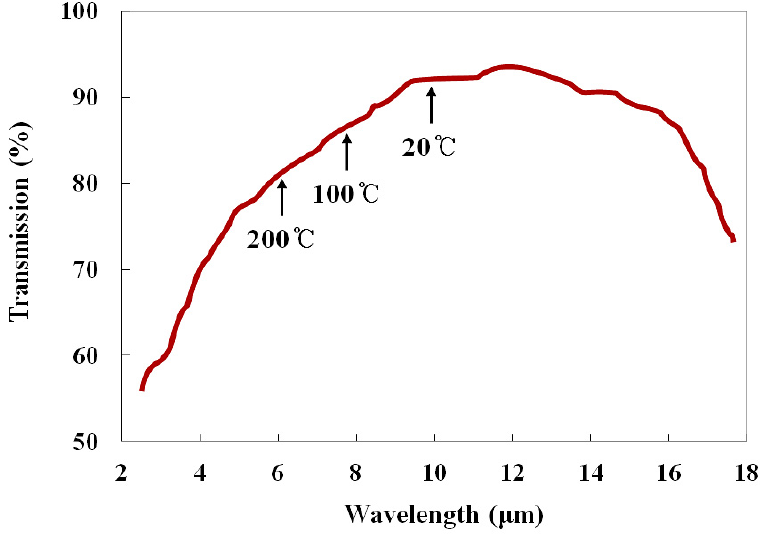
Figure 2. Transmission rates of a silver halide optical